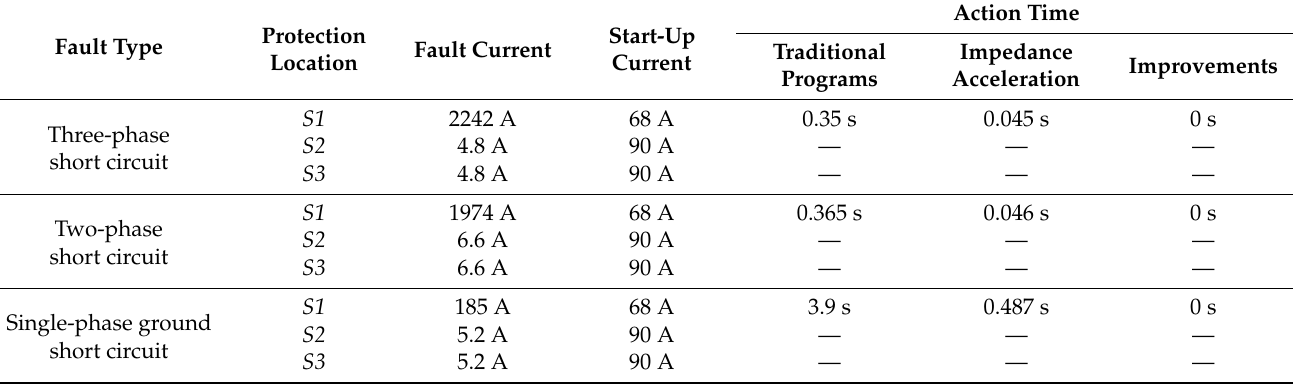
Table 9. Operating time of different protection schemes in the case of line AB via 0 Ω ground resistance